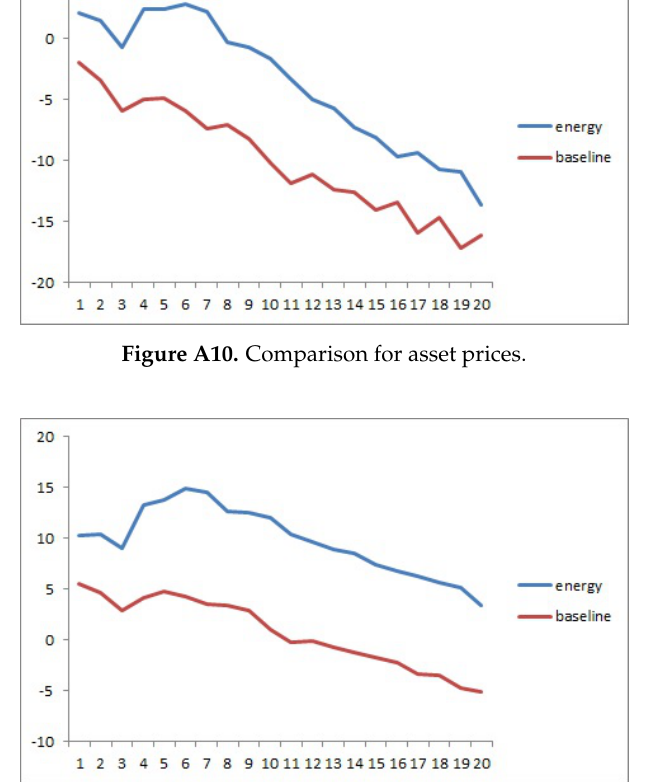
Figure A11. Comparison for bubbles